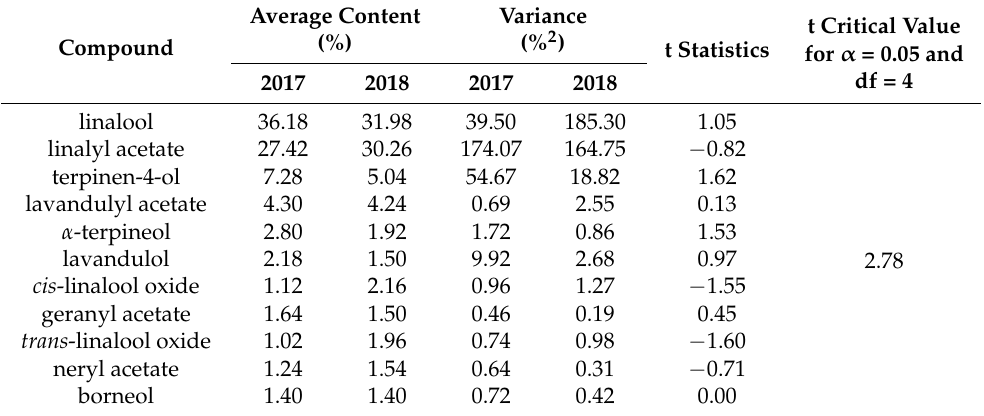
Table 7. The results of paired t -test (two-sided) for top lavender oil component change trends between 2018 and 2017 from five different cultivars. The sample size for statistics was 5 (n = 5), and the degrees of freedom df = 4. The null hypothesis was that the content difference between the years is equal to 0. The alternative hypothesis was that it is not equal to zero. Average Compound